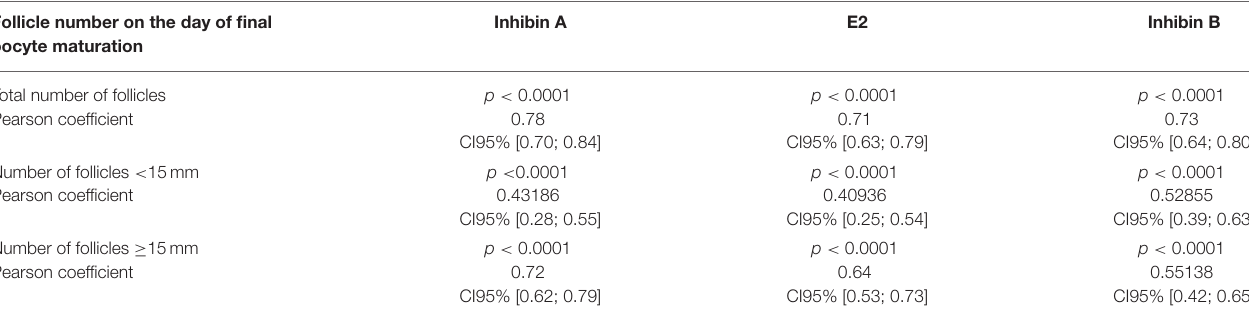
TABLE 3 | Correlations on the day of final oocyte maturation between total numbers of follicles/numbers of follicles < 15 mm/numbers of follicles ≥ 15mm and Inhibin A, estradiol, and Inhibin B. Follicle number on the day of final oocyte